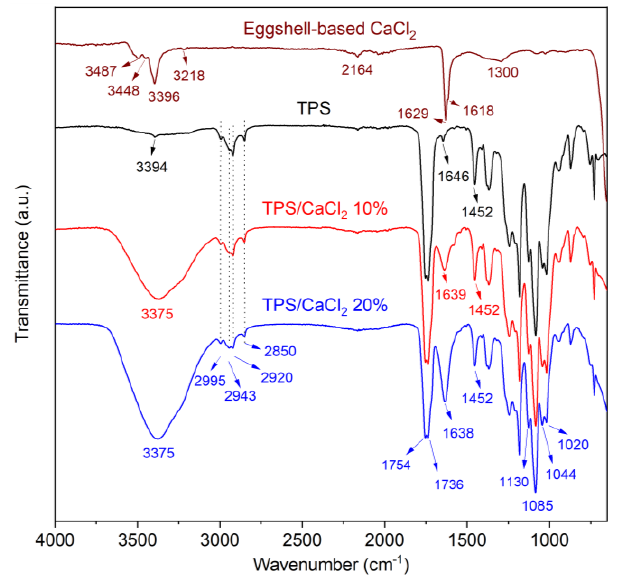
Figure 1. FTIR spectra of CaCl 2 extracted from eggshells, virgin TPS, TPS/CaCl 2 10 wt% and TPS/CaCl 2 20 wt% composite films.